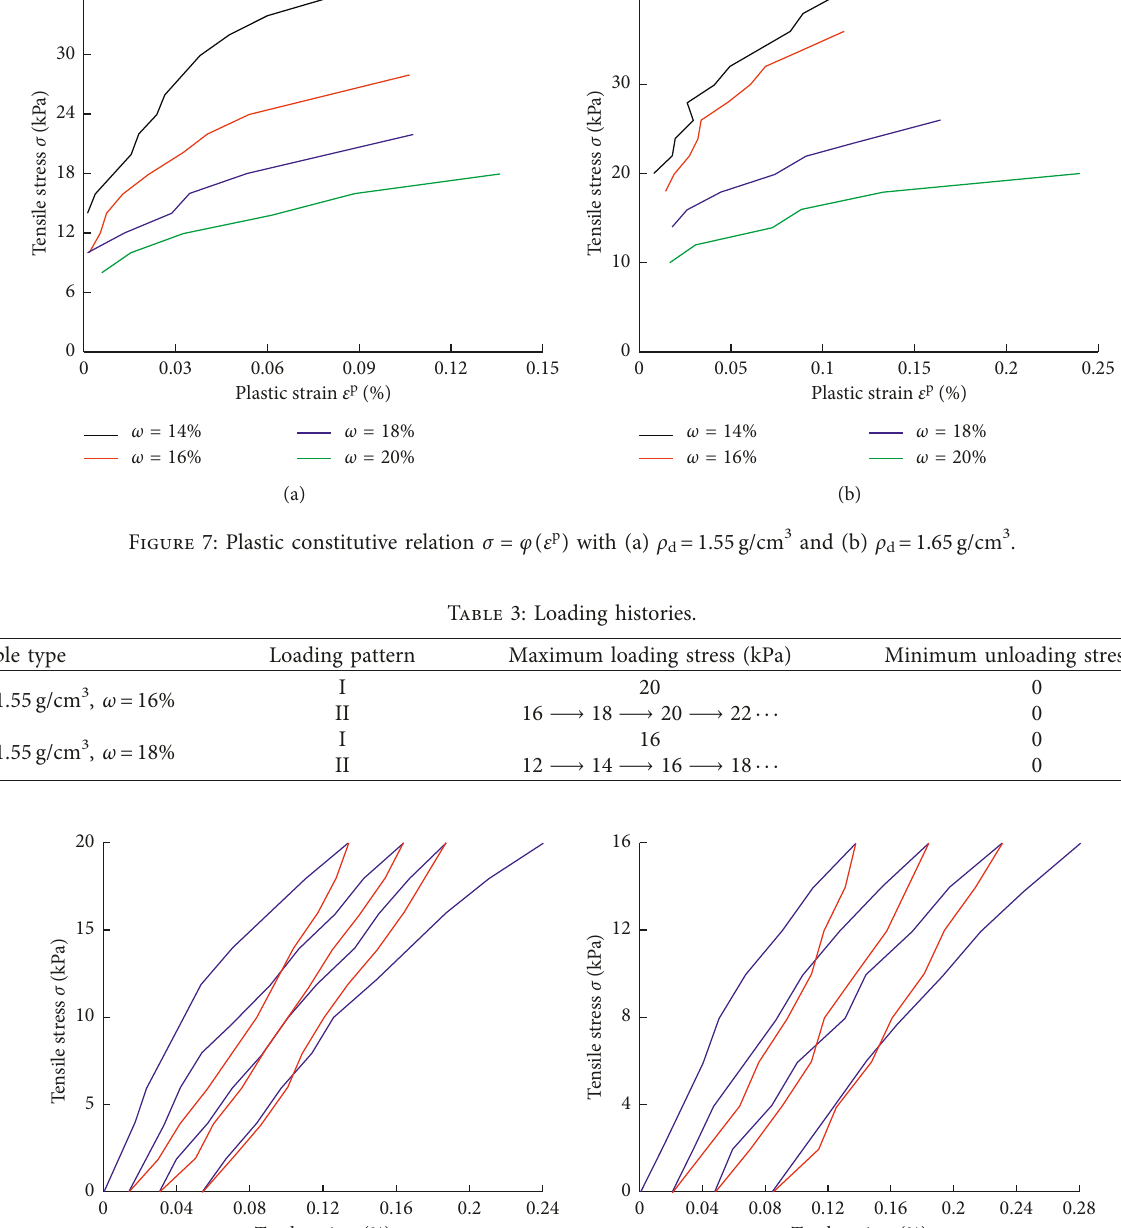
Figure 8: Stress-strain curves of the cyclic tensile tests for loading pattern I: (a) w � 16%; (b) w �